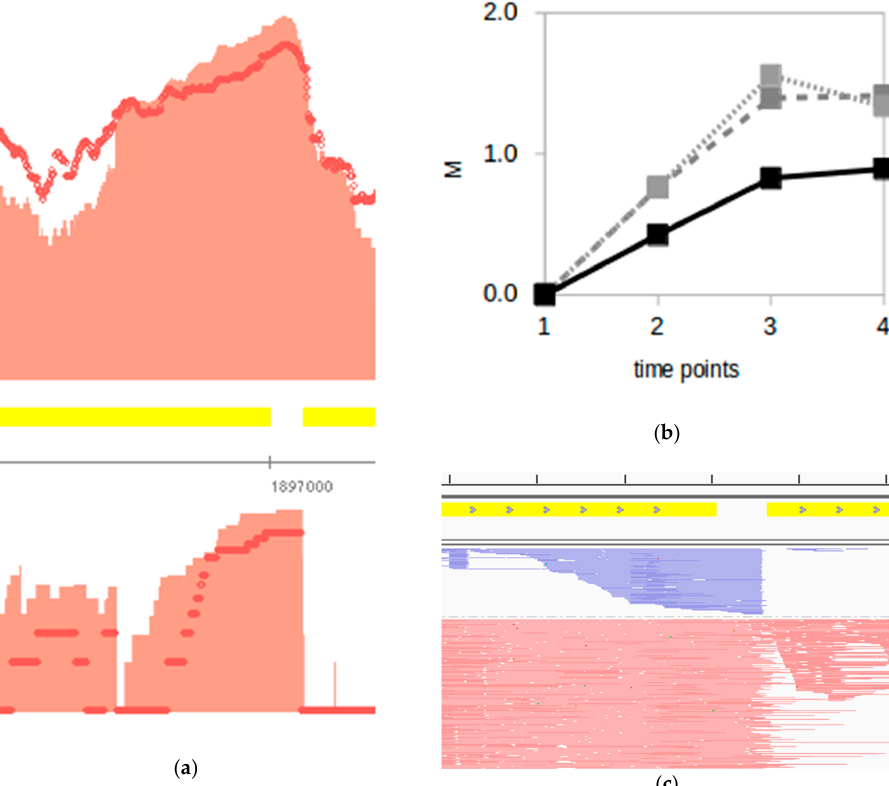
Figure 6. Example of sense/antisense processing during H. salinarum growth. ( a ) TPS (TPS_7176_1, top panel) and aTPS (TPS_15790_1, bottom panel) are located between dppA2 and dppB2 (VNG_RS09900 and VNG_RS09905 loci , 600 bp zoomed in out of a ~1.7 kbp gene), which encode members of a dipeptide ABC transporter system. Coding sequences are in forward strand (yellow rectangles) thus 5 ′ → 3 ′ direction is left to right, upper panel shows dRNA-seq data for forward strand and lower panel for reverse strand. ( b ) dppA2, dppB2 and dppC2 gene log 2 fold-change (M) between transcriptome data in different time points relative to the early exponential phase from [35] (time point 1: early exponential, 2: mid-exponential, 3: late exponential, 4: stationary, filled black: dppA2 , dashed grey: dppB2 data, dotted light grey: dppC2 ). ( c ) Sample of aligned reads in the same window of ( a ) but not log scaled. Reads aligned to the reverse (antisense to dppA2 ) and forward strands are shown in blue and red, respectively (reads in red cropped vertically and horizontally for clarity since they are ~10-fold more abundant in this window). Tick marks are 100 bp apart.